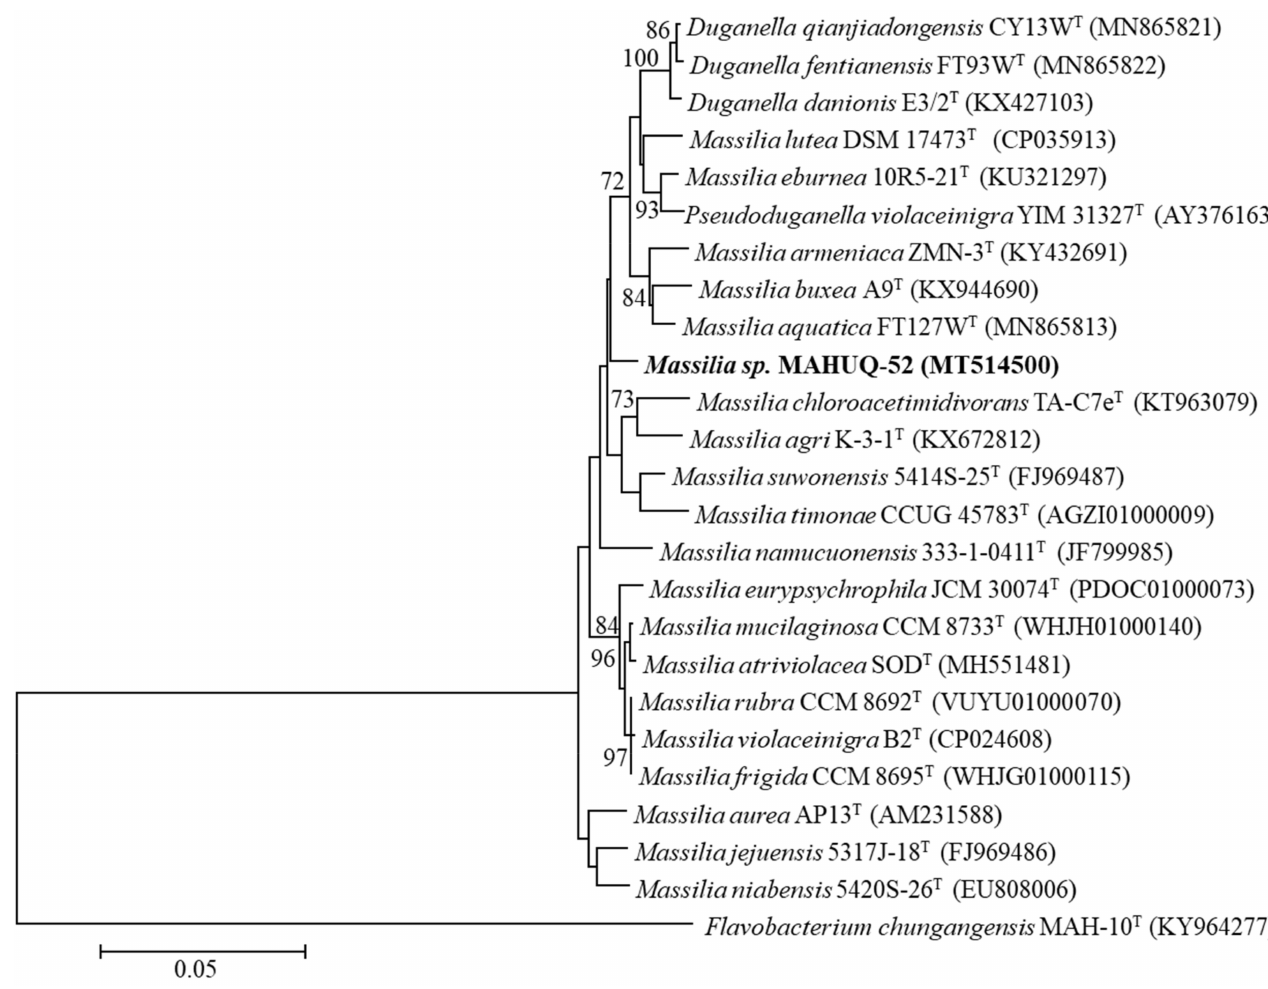
Figure 1. The neighbor-joining (NJ) tree based on 16S rRNA gene sequence analysis showing phylogenetic relationships of strain MAHUQ-52 and the related type strains. Bootstrap values more than 70% based on 1000 replications are shown at branching points. Scale bar, 0.05 substitutions per nucleotide